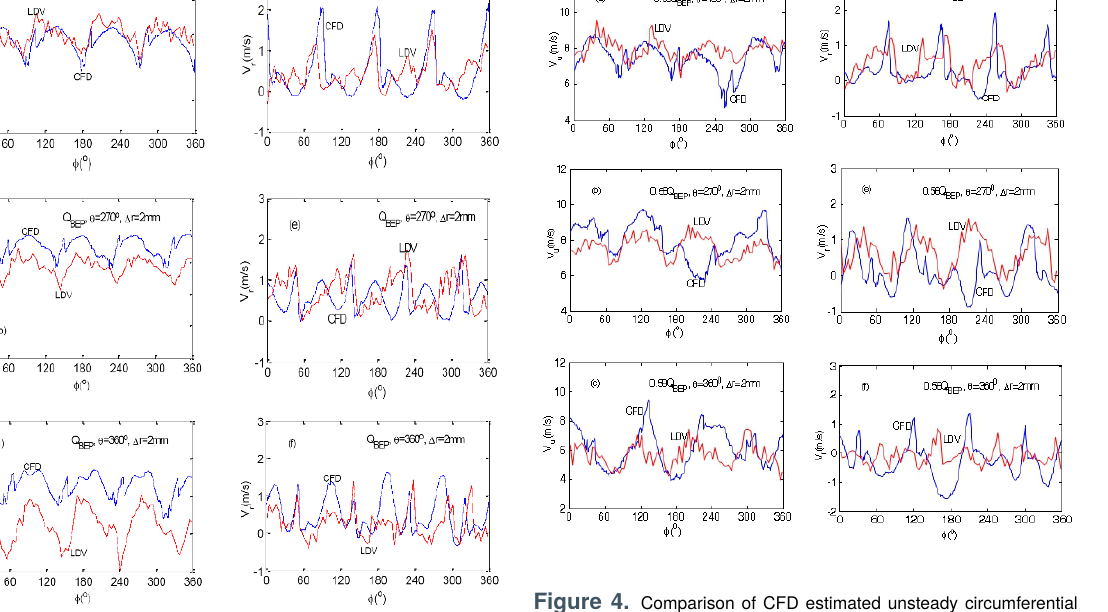
Figure 3. Comparison of CFD estimated unsteady circumferential and radial velocity components of water at point 2mm be- hindimpellerwiththoseobservedbyLDVatbestefficiency point.